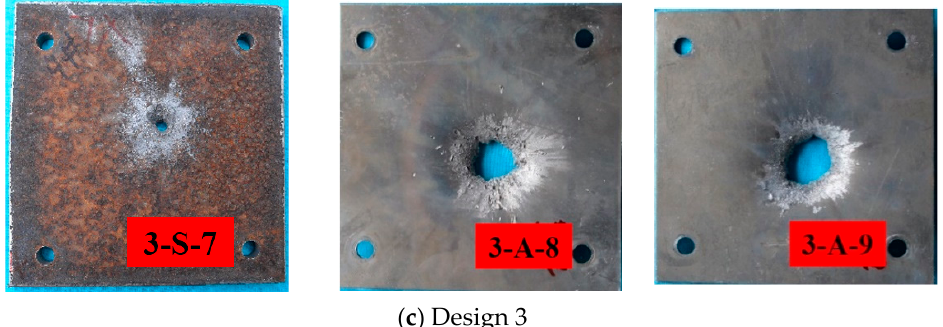
Figure 8. Impacted steel and aluminum plates in penetration experiments for design 1~3 ( a – c ): S for the steel plate and A for the aluminum plate.